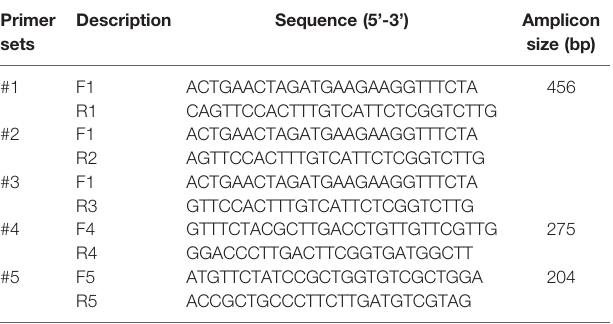
TABLE 2 | Design of speci fi c RPA primer